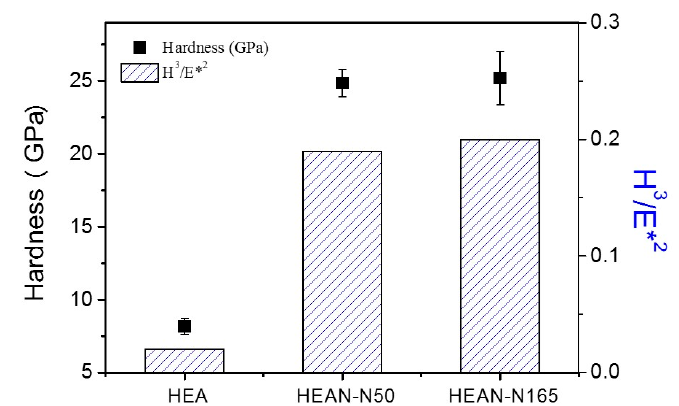
Figure 5. Hardness (H) and the H 3 /E* 2 values of the CrVTiNbZr(N) coatings with different nitrogen flow rates (HEA, HEAN ‐ N50 and HEAN ‐ N165) measured by nano ‐ indentation. Figure 6 shows the variation of average friction coefficient and wear rate of the CrVTiNbZr(N) coatings with different nitrogen flow rates. The wear rate of the CrVTiNbZr(N) (HEAN ‐ N50 and HEAN ‐ N165) decreased substantially compared to that of the HEA. The HEAN ‐ N165 had lowest wear rate of 3.23 × 10 − 7 mm 3 /Nm, which was much lower than that of HEA (1.46 × 10 − 5 mm 3 /Nm) and HEAN ‐ N50 (7.29 × 10 − 6 mm 3 /Nm). The average friction coefficients of HEA and HEAN ‐ N50 coatings were about 0.84 and 0.81, respectively. The average friction coefficient of the HEAN ‐ N165 decreased to ~0.72, which was lower than that of HEA and HEAN ‐ N50. Compared with the results of hard ‐ ness test, it can be found that the wear resistance and hardness of the coating are positively correlated with H 3 /E* 2 , and the HEAN ‐ N165 coating with the highest hardness (25.2 GPa) and H 3 /E* 2 (0.2 GPa) possessed the best wear resistance. The increase of hardness and